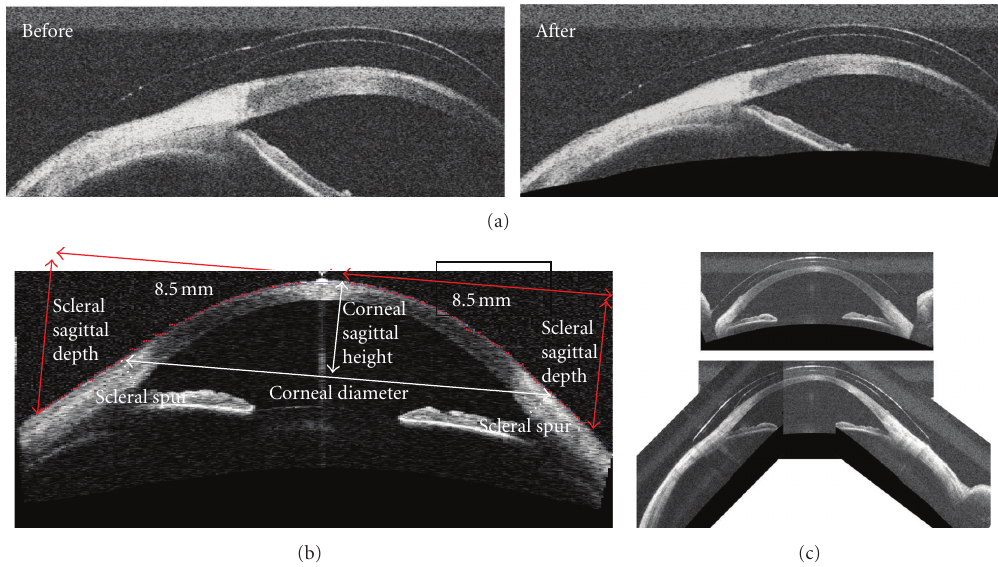
Figure 4: (a) OCT scans before and after dewarping. (b) A normal cornea imaged with a time-domain anterior segment OCT system. The image dimension is 18mm and consists of 256 axial scans acquired in 0.128 second. (c) Vertical scan with lid artifact (red arrows) and montage of images obtained in deviated gaze to create image of entire anterior globe contour absent lid artifact.